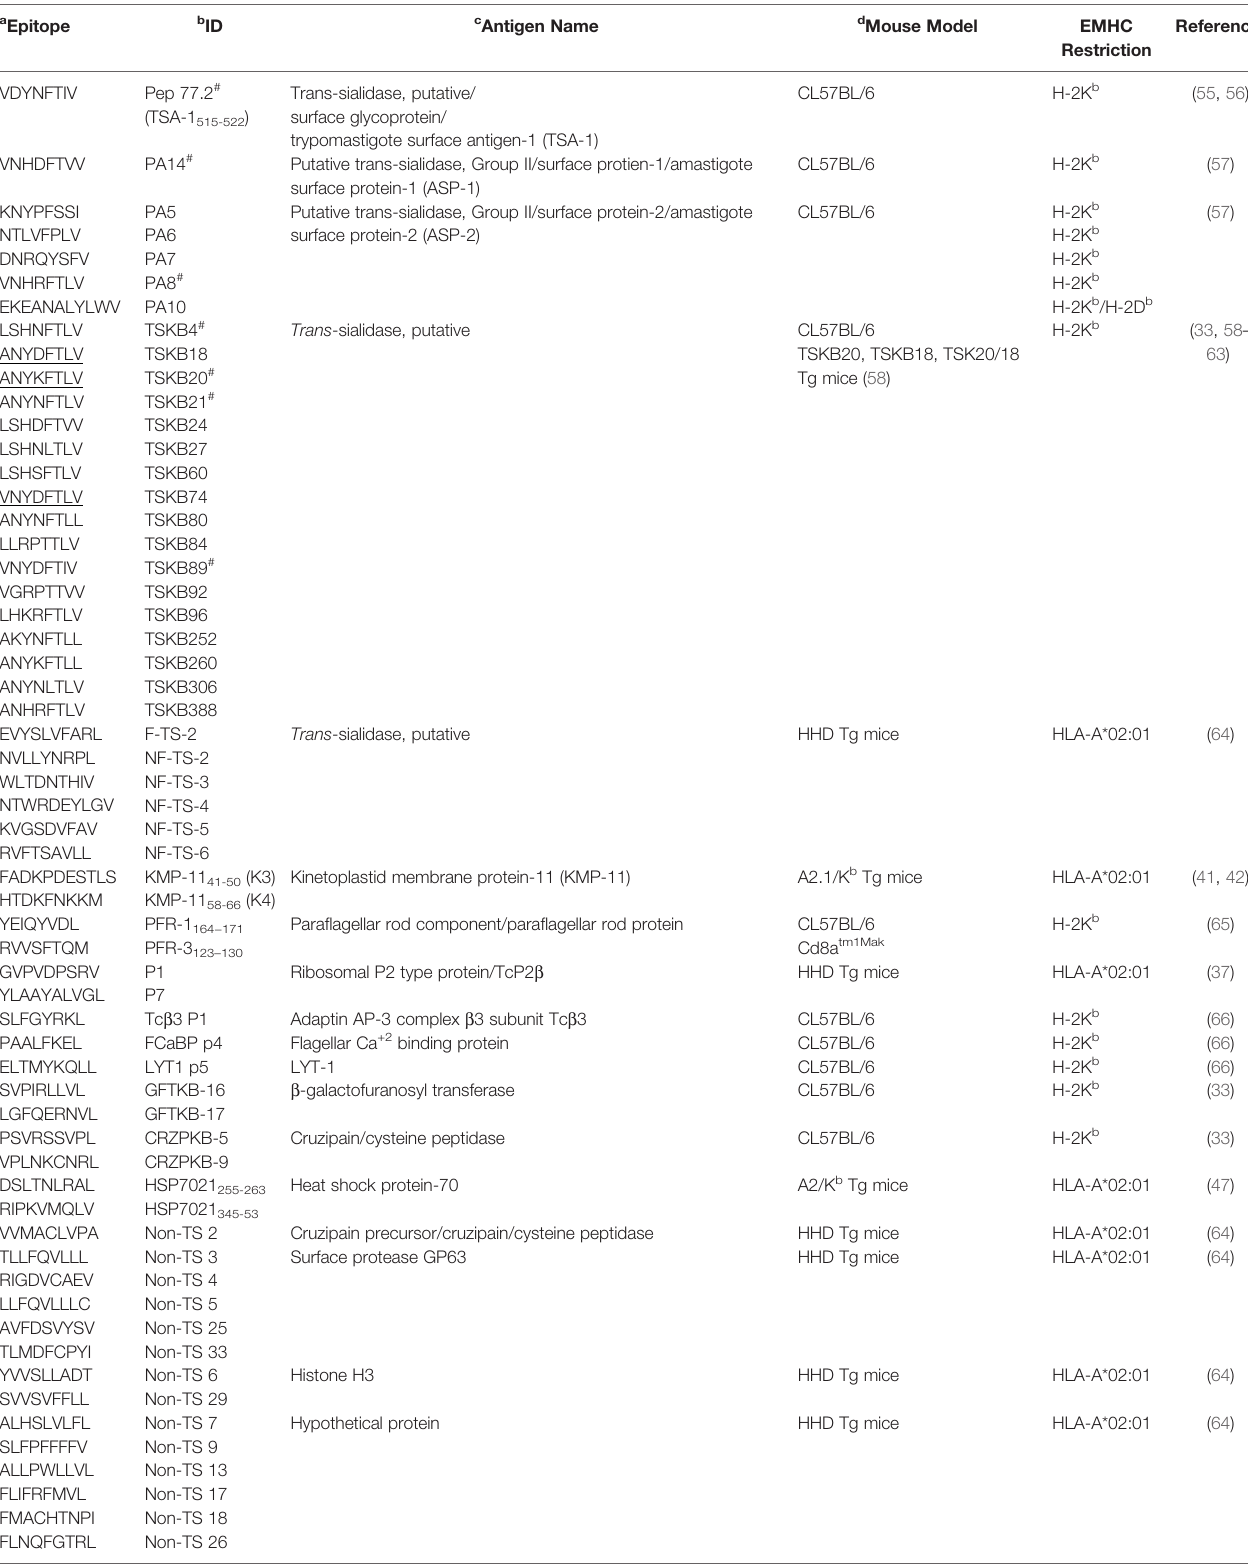
TABLE 2 | T. cruzi epitopes recognized by CD8 + T cell from mice (not tested in Chagas disease